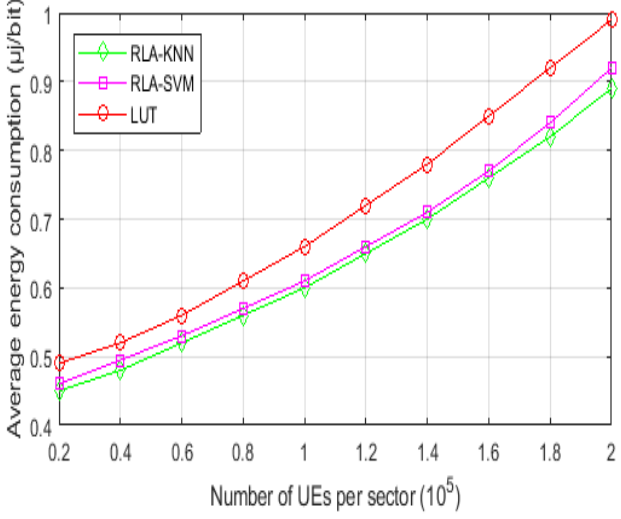
Figure 11. Average energy consumption.